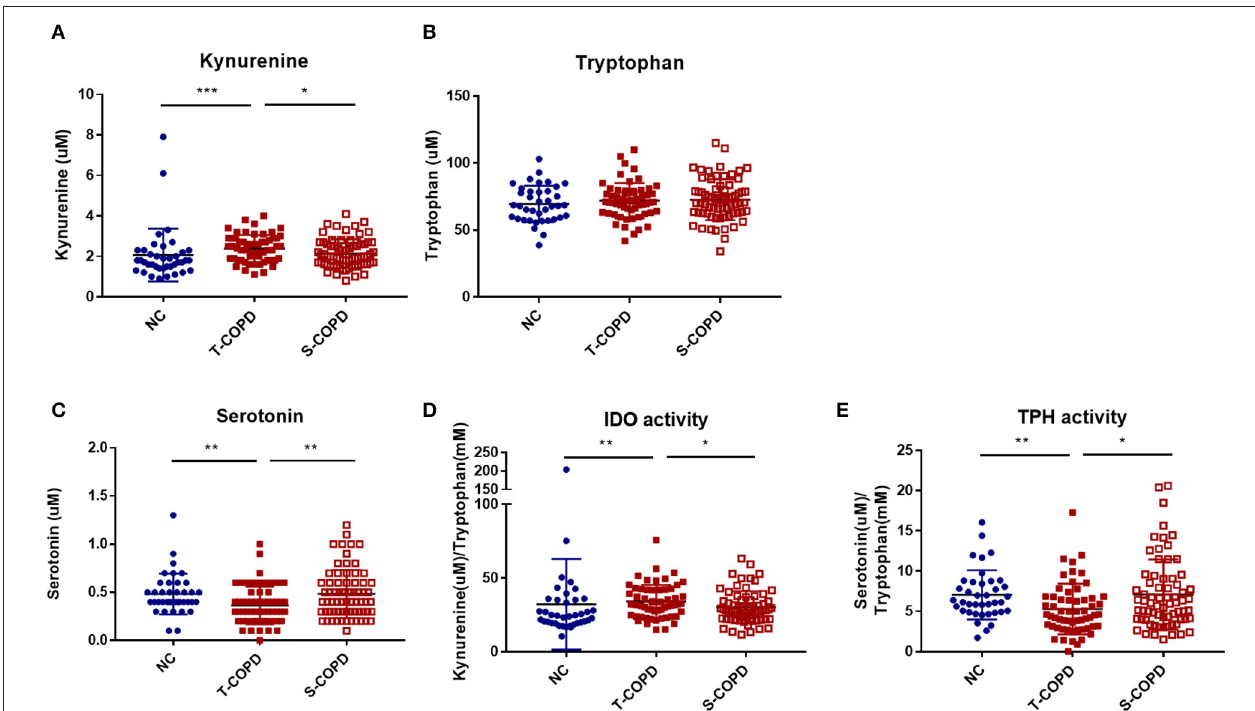
FIGURE 4 | Alternation of tryptophan metabolism in patients with T-COPD. Serum concentrations of (A) kynurenine, (B) tryptophan, and (C) serotonin are shown in scatter plots. (D) and (E) indicate IDO and TPH activities, respectively. Data are presented as the mean ± standard error of the mean. * P -value < 0.05, ** P -value < 0.01, and *** P -value < 0.001. NC, normal control; T-COPD, TB-associated COPD; S-COPD, smoking-associated COPD; IDO, indoleamine dioxygenase; TPH, tryptophan